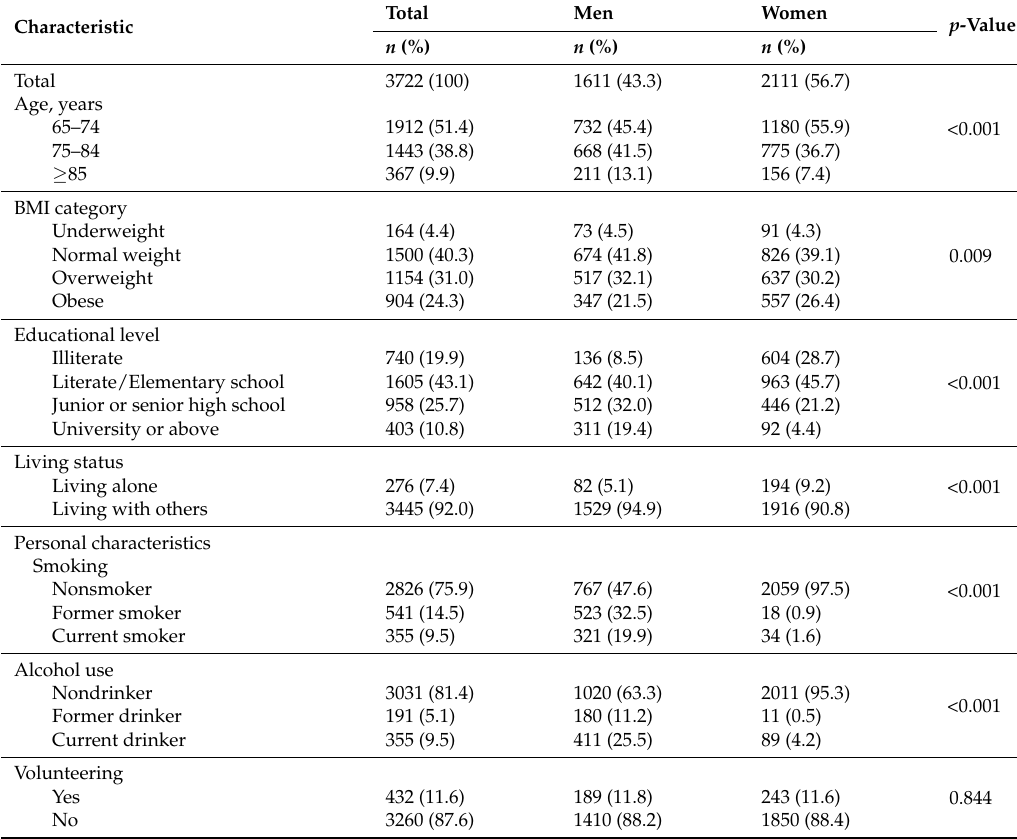
Figure 1. The Directed Acyclic Graph for the Associations between BMI, Covariates and the Study Outcomes. Table 1. Demographic Characteristics of Participants (Total n = 3722).